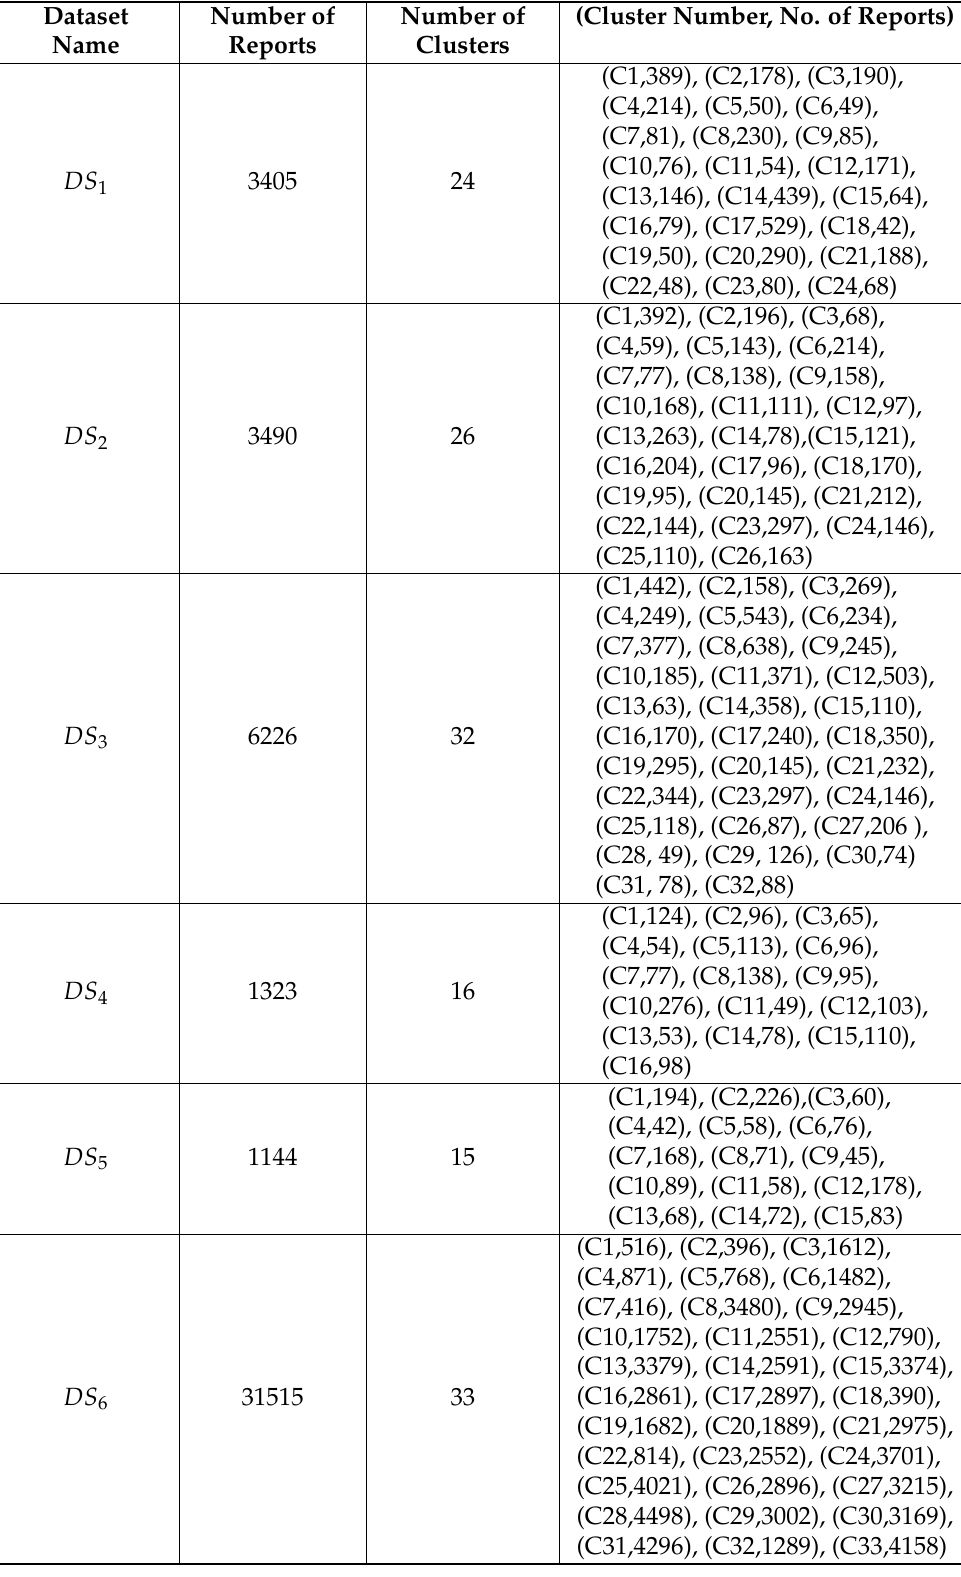
Table 1. Description of Datasets and Clustering of